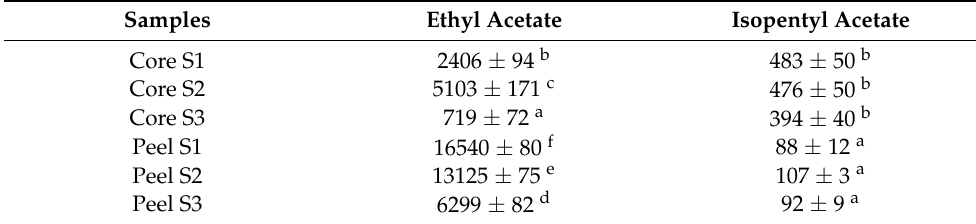
Table 6. Volatile concentration ( µ g Kg − 1 ) of ethyl acetate and isopentyl acetate in pineapple core and peel